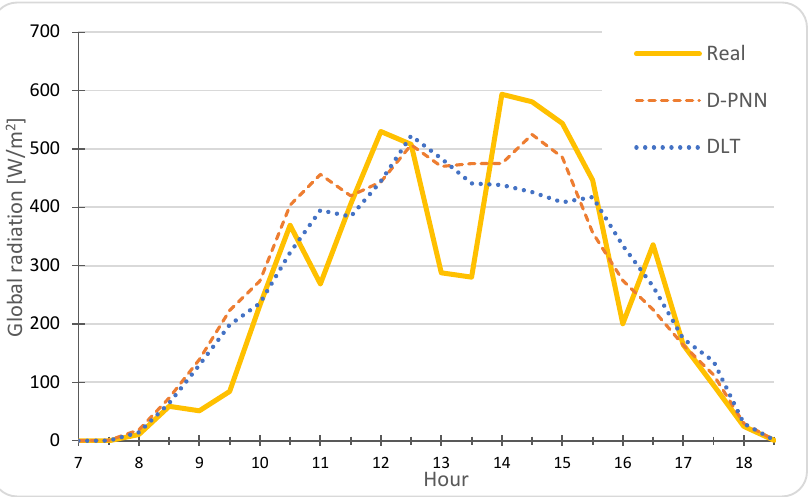
Figure 6. 14.11.2015, Tajoura City, solar-radiation prediction day RMSE: DNN = 89.22, DLT = 91.67 [W/m 2 ].